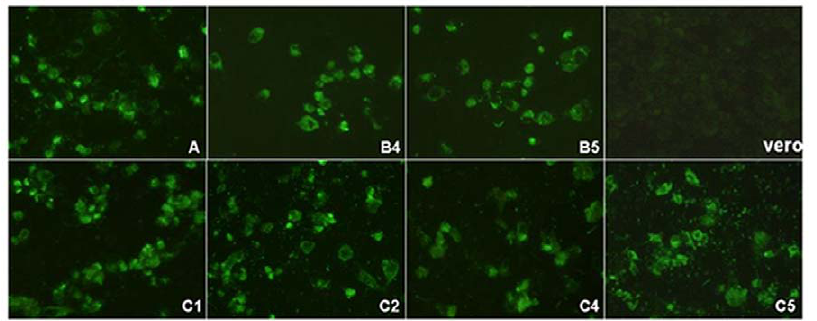
Figure 1. Mab 1C6 detects variable EV71 strains. IFA of Vero cells individually infected with different EV71 strains. Cells were labeled with Mab 1C6 followed by anti-mouse FITC secondary antibody.